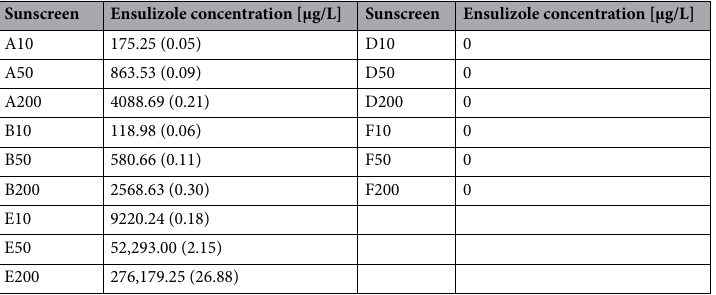
Table 2. Ensulizole concentrations of the tested sunscreens (standard deviations are given in parenthesis, n = 3).